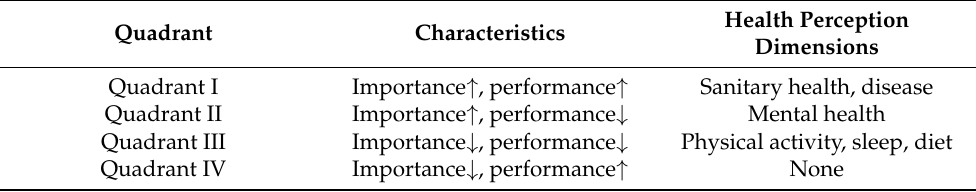
Table 7. Distribution of dimensions of health